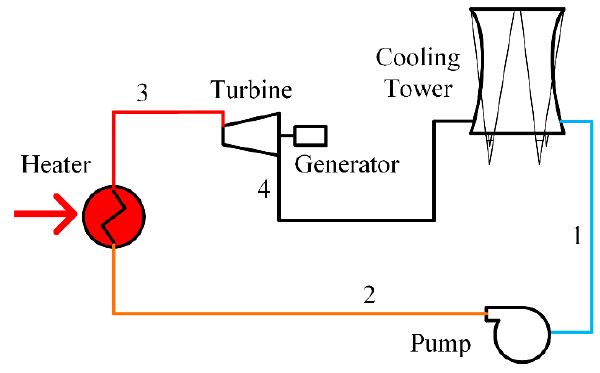
Figure 1. Schematic diagram of the power plant.